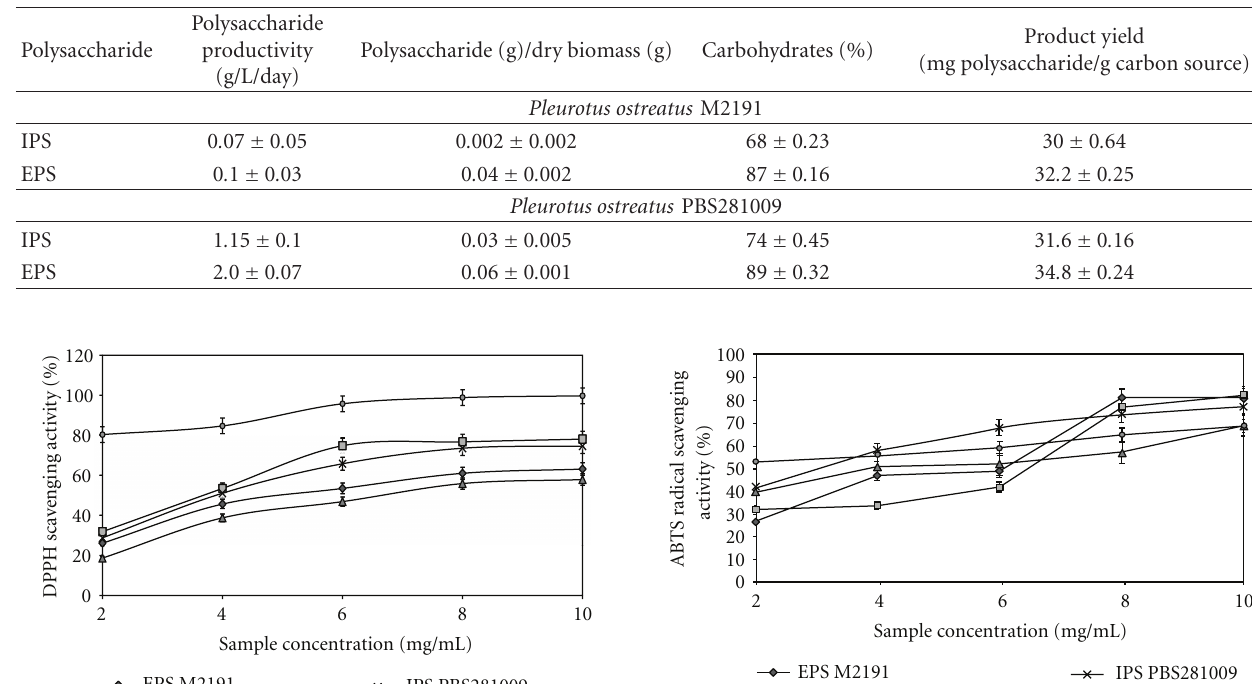
Table 1: EPS and IPS production from the submerged culture of Pleurotus ostreatus M2191 and PBS281009 after 10 days of batch fermentation.